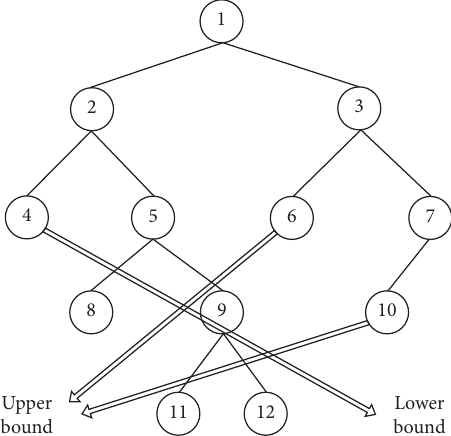
Figure 2: Brief plot of binary bounds.